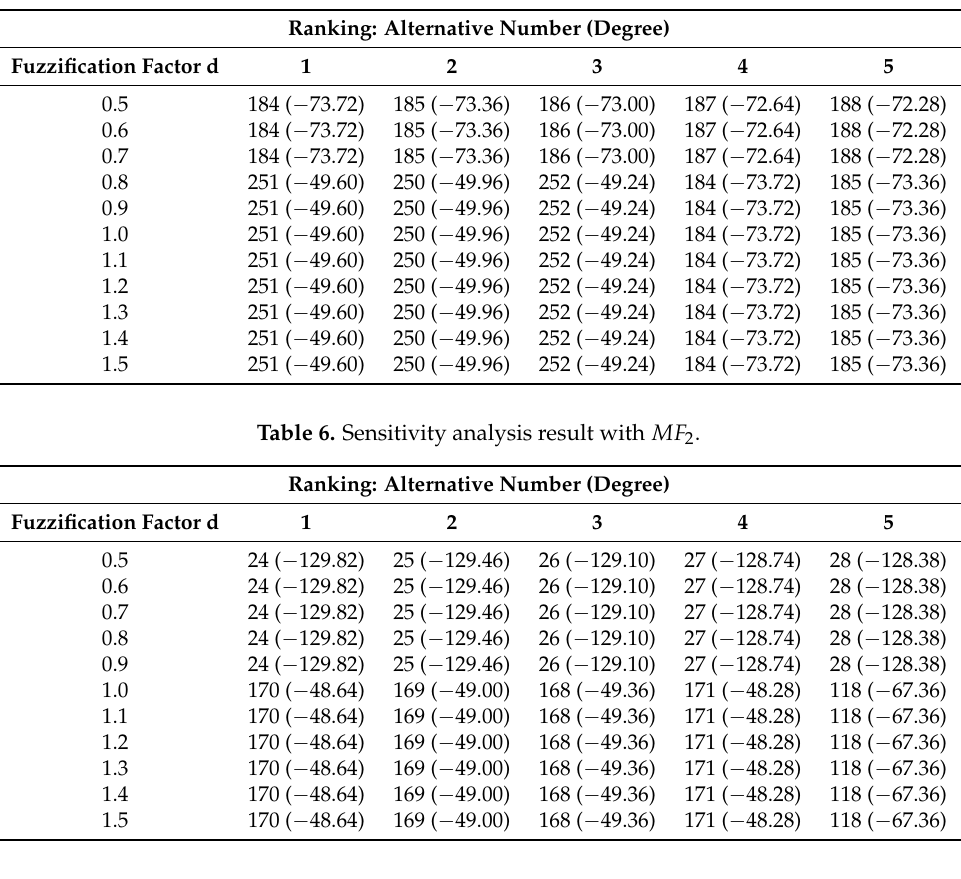
Table 5. Sensitivity analysis result with MF 1 .